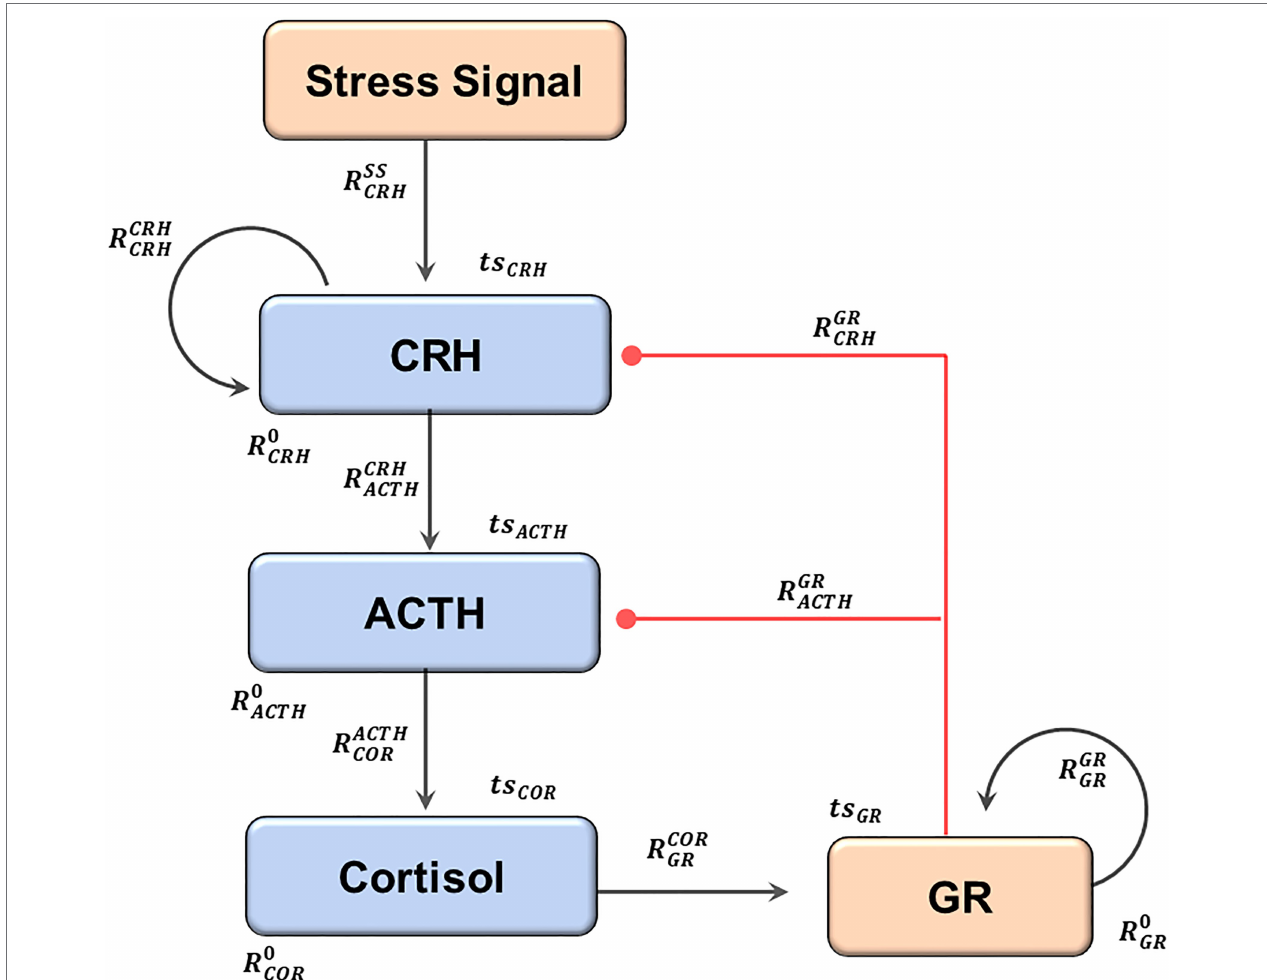
FIGURE 1 | The structure of the current model. An elevation of the stress signal results in the sequential release of CRH, ACTH, and Cortisol. Cortisol activates GR, which then inhibits both CRH and ACTH, forming the negative feedback. Two positive feedback loops regulate CRH and GR. The black arrows indicate activation, and the red lines with dot heads indicate inhibition. The regulatory parameters (capital R) and the time series parameters (lower case ts) are labeled near the reactions they control. The subscripts describe the identities of the regulated components, and the superscripts describe the regulating components (0 if not specified). The full names of the components, as well as the modeling justifications, are elaborated in the